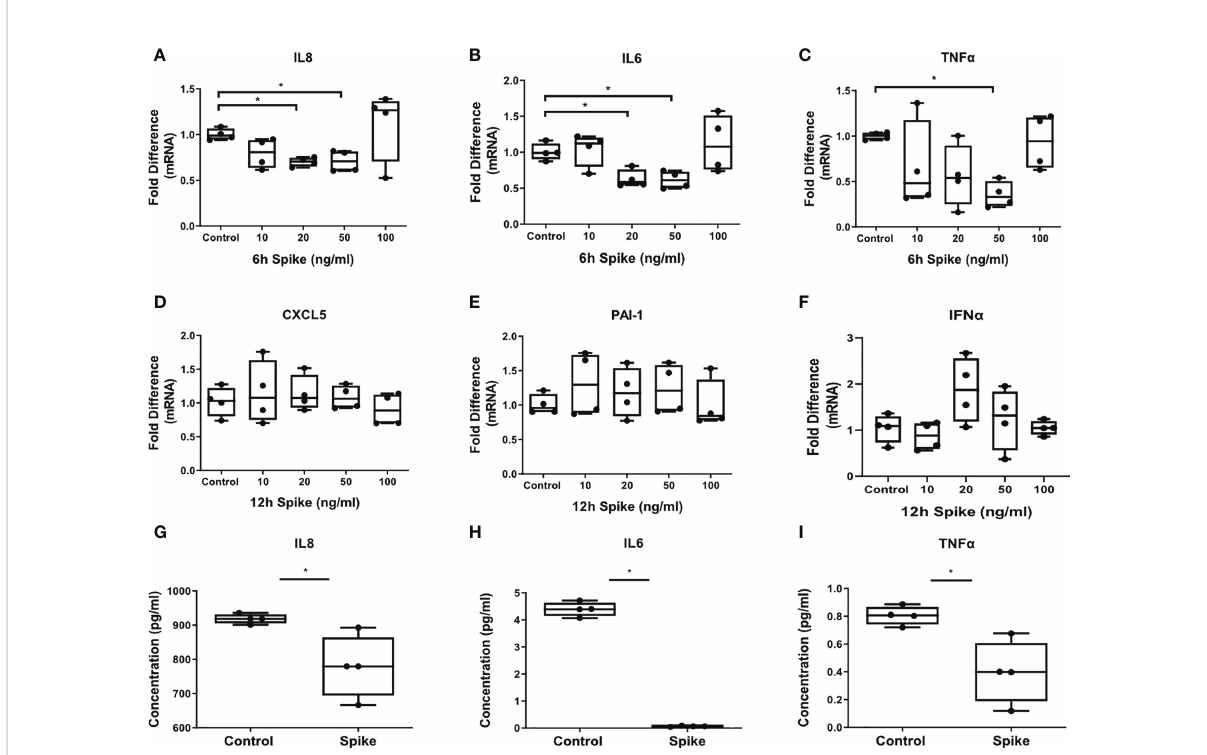
FIGURE 1 SARS-CoV-2 S protein suppressed the expression and production of pro-in fl ammatory cytokines in A549 cells. A549 cells were treated with different concentrations of SARS-CoV-2 Spike-Membrane recombinant fusion protein (10, 20, 50, 100 ng/ml) for 6 or 12 hours. (A – C) mRNA expression of IL6, IL8 and TNF a decreased upon SARS-CoV2 Spike stimulation for 6 hours compared to untreated control cells. (D – F) No effect was observed for the expression of CXCL5, PAI-1 and IFN a at 12 hours following stimulation. (G – I) Secretion of IL8, IL6 and TNF a decreased upon SARS-CoV2 Spike stimulation (50ng/ml) for 12 hours. Data are illustrated in box-and-whiskers and plotted as median with range (n=4 biological replicates per group). Statistical analysis was performed with Kruskal - Wallis test (A – F) and Mann – Whitney U test (G – I) . Results are representative of three independent experiments. *p <